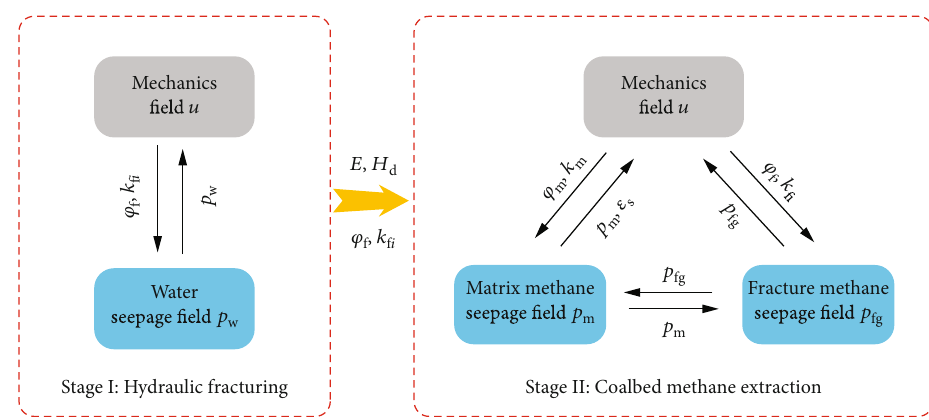
Figure 2: Relationship between all the modules